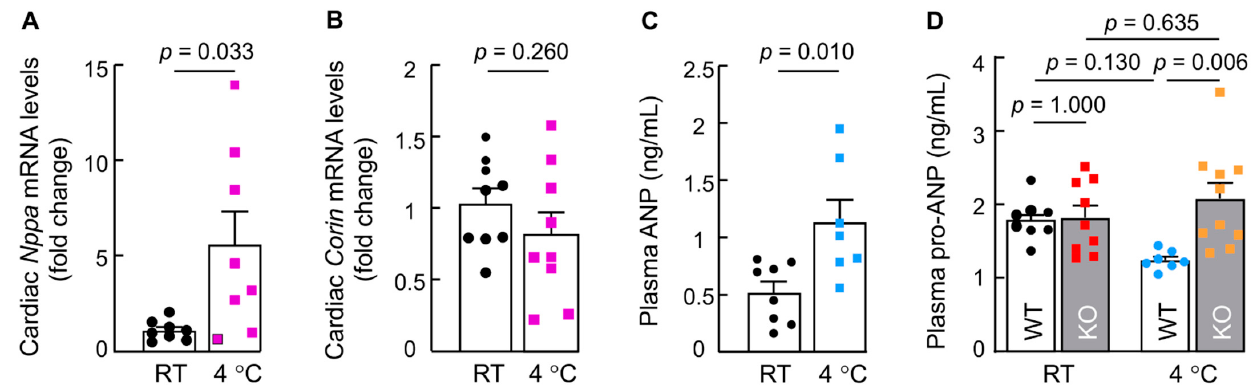
Figure 5. Cardiac Nppa and Corin expression and plasma ANP and pro-ANP levels in mice upon cold exposure. ( A , B ) Cardiac Nppa ( A ) and Corin ( B ) mRNA levels in 4-month-old male WT mice at RT and 4 ° C were analyzed with qRT-PCR ( n = 8–9). ( C ) Plasma ANP levels in 4-month-old male WT mice at RT and 4 ° C were analyzed by ELISA ( n = 7–8). ( D ) Plasma pro-ANP levels in 4-month-old male WT and corin KO mice at RT and 4 ° C were analyzed by ELISA ( n = 7–10). Data of mean ± SEM are shown. p values were assessed by Student’s t test ( A – C ) or two-way ANOVA and Tukey post hoc analysis ( D ).